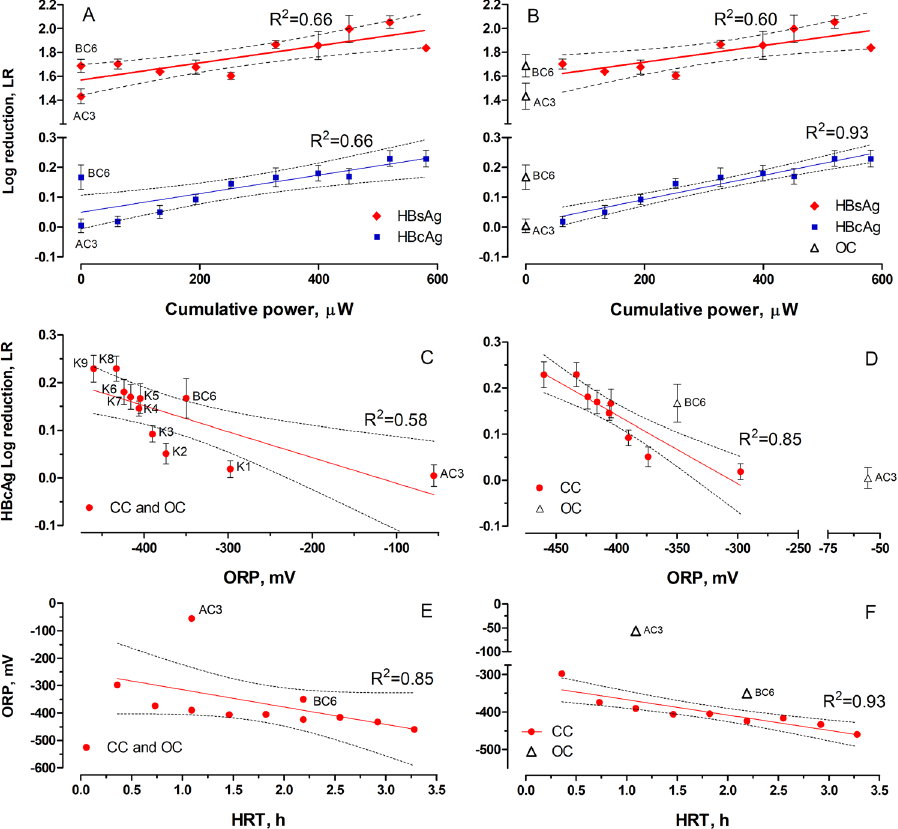
Figure 5. Linear regression models fitted to the experimental data. ( A , B ) Effect of cumulative power on both antigens when open circuit controls are included ( A ) and excluded ( B ) from the model. C and D – influence of ORP on log reduction of core antigen, when open circuit controls are included ( C ) and excluded ( D ). ( E , F ) Influence of HRT on ORP when the open circuit controls are included ( E ) and excluded ( F ). Dashed lines represent 95% confidence interval. Error bars represent standard